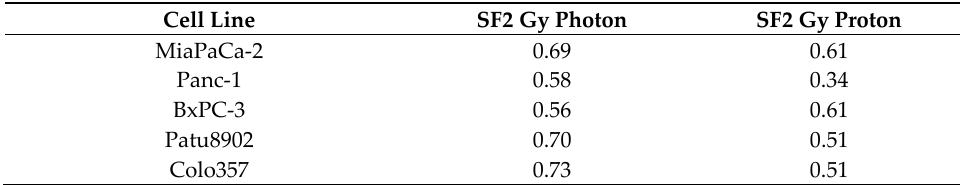
Table S2. SF2 values of PDAC cell lines after photon and proton irradiation.